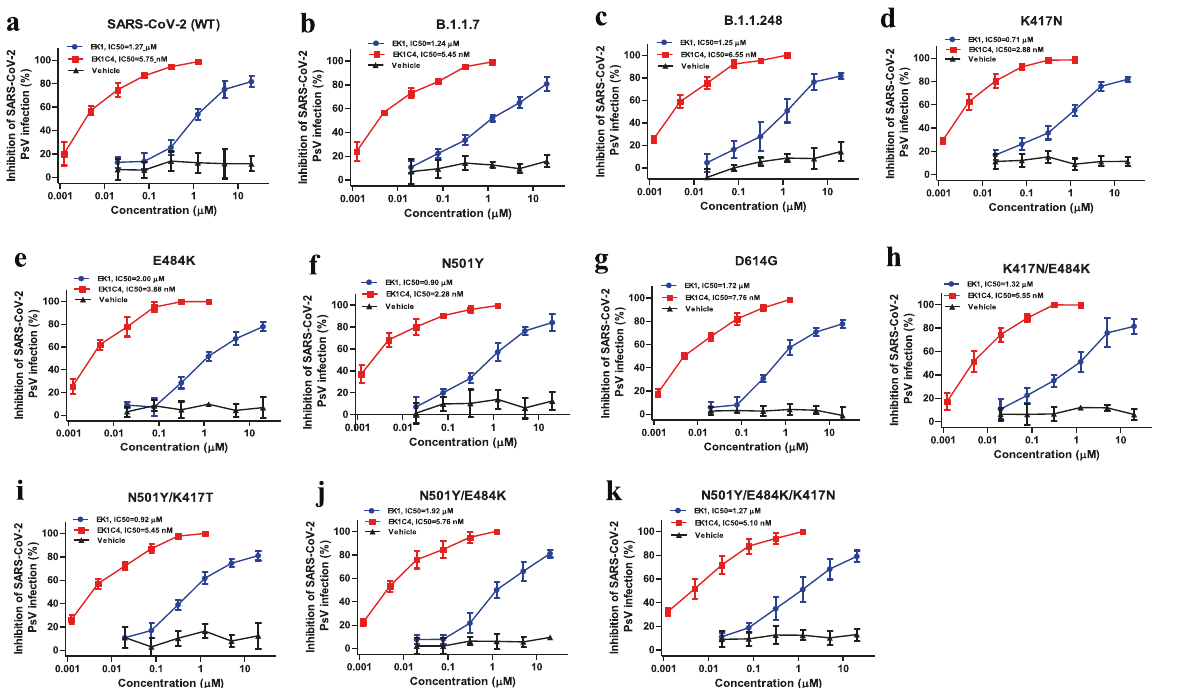
Fig. 2 Broad-spectrum inhibitory activity of EK1-peptides against infection mediated by mutant SARS-CoV-2 S proteins. a Antiviral activity of EK1 and EK1C4 against wild-type SARS-CoV-2 PsV infection on Caco2 cells. b , c Inhibitory activity of EK1 and EK1C4 against infection mediated by S protein of SARS-CoV-2 B.1.1.7 ( b ) and B.1.1.248 ( c ) variants on Caco2 cells. d – g Anti-SARS-CoV-2 ef fi cacy of EK1 and EK1C4 on PsV infection mediated by the S protein with single mutations, including K417N ( d ), E484K ( e ), N501Y ( f ), or D614G ( g ), respectively on Caco2 cells. h-k Antiviral ef fi cacy of EK1 and EK1C4 against PsV infection mediated by the S protein with combinational mutations, including K417N/ E484K ( h ), N501Y/ K417N ( i ) N501Y/E484K ( j ), and N501Y/ K417N/E484K ( k ), respectively, on Caco2 cells. Experiments were repeated twice, and the data are expressed as means ±